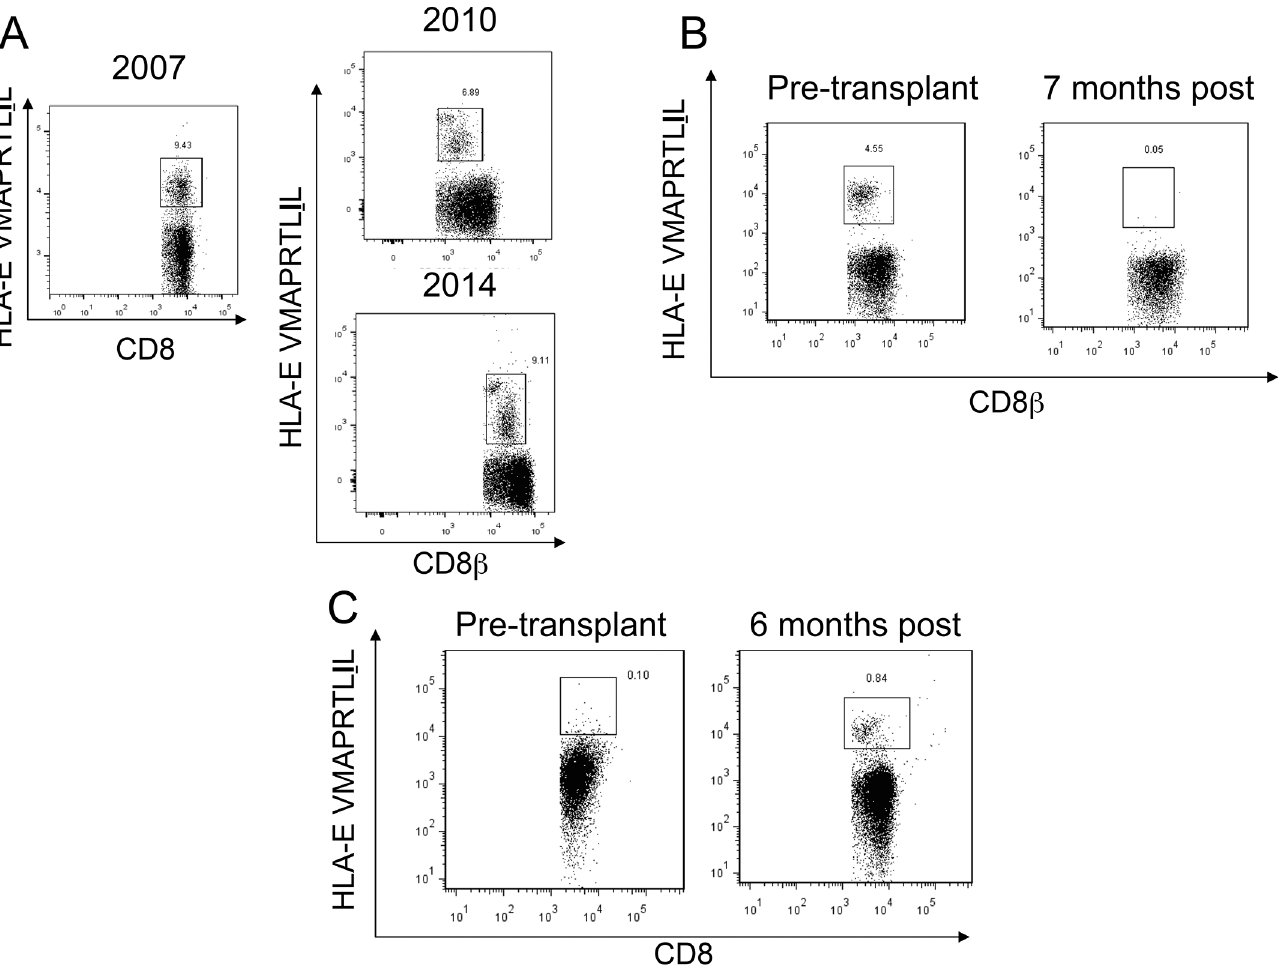
Fig 2. Appearance of UL40 specific T cells differs in lung transplant recipients to a healthy non-transplant donor. The percentage of UL40-specific T cells remains stable in a healthy non-transplant donor over a seven-year period (A). UL40-specific T cells are present in the blood of LTR #10 prior to transplant but were not observed at any other sampling time point post transplantation (B). UL40-specific T cells are not present in the blood of LTR #2 prior to transplant but appear in the blood 6 months post-transplant, coincident with AR1 (C). Plots showing CD8 β are gated only on lymphocytes, whereas those showing CD8 are gated on CD3 positive lymphocytes. Numbers show UL40-specific T cells as a percentage of total CD8+ T